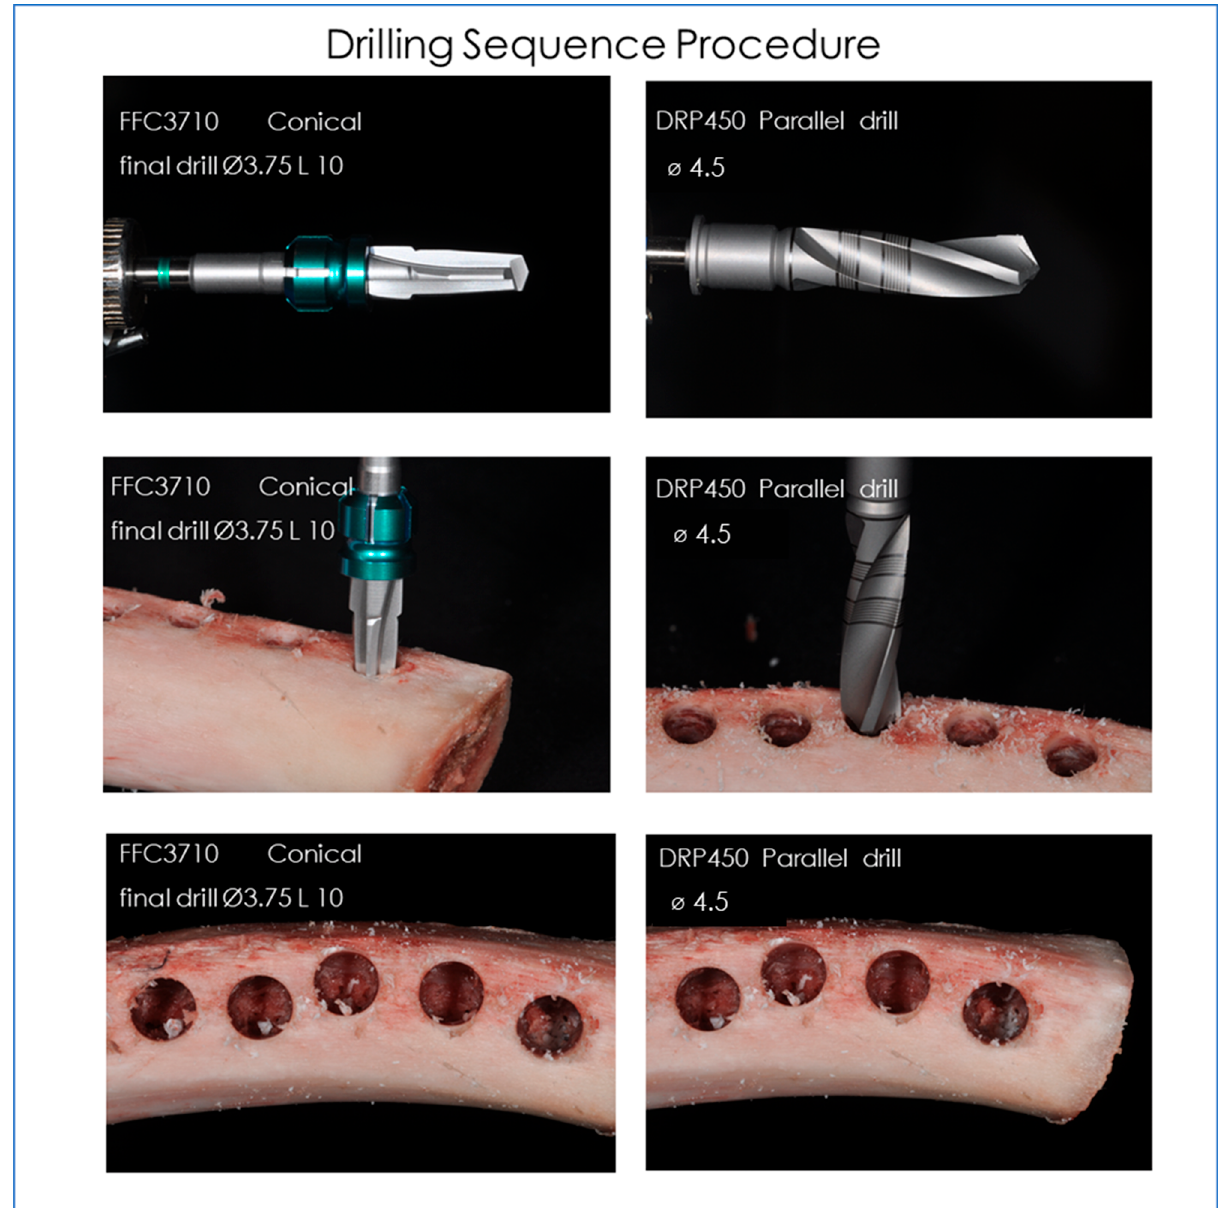
Figure 2. Details of the drilling sequence (continued) .